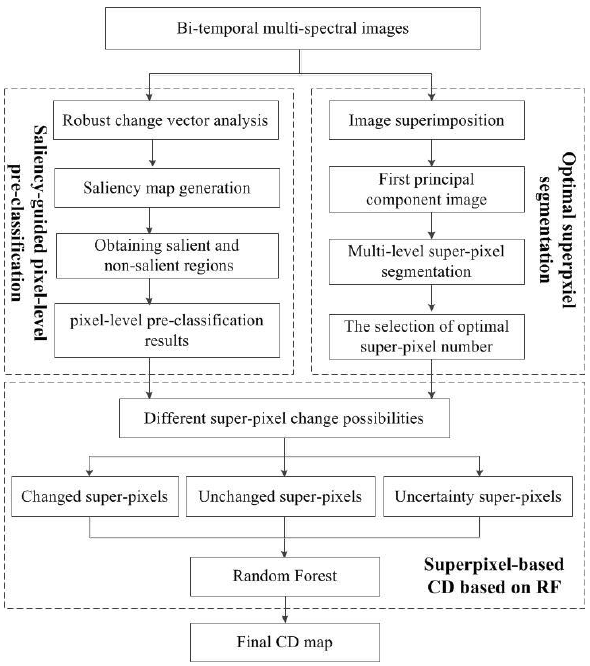
Figure 1. Flowchart of the proposed